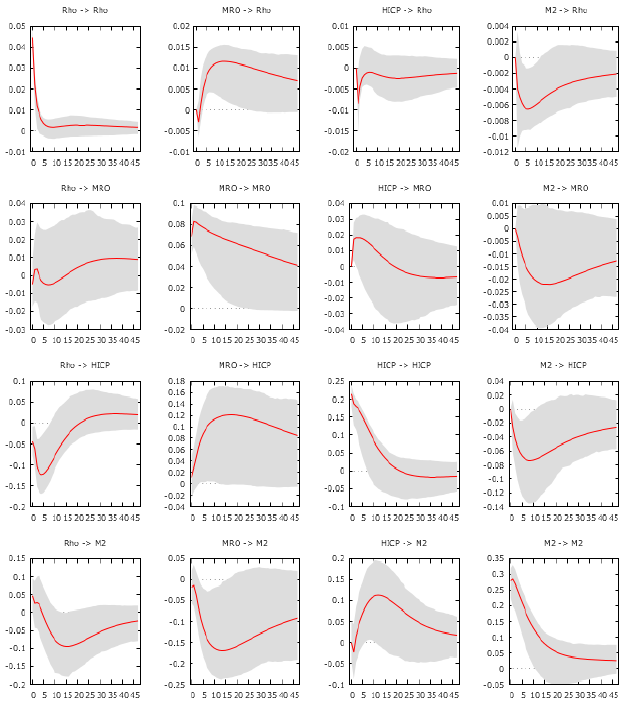
Figure 5. Impulse response. The figure reports 90% bootstrap coverage areas. Bootstrapped confidence intervals are based on 1000